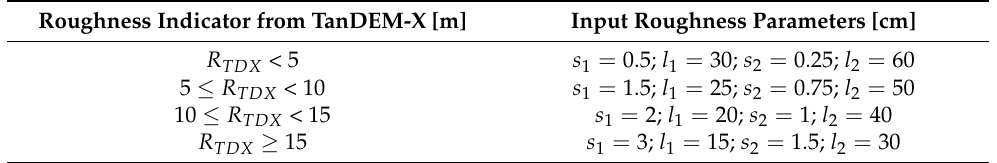
Table 3. Surface roughness parameter sets of each layer (vertical RMS height s , horizontal correlation length l ) as input for the multi-layer SPM based on TanDEM-X derived roughness indicator R TDX . Roughness Indicator from TanDEM-X [m] Input Roughness Parameters